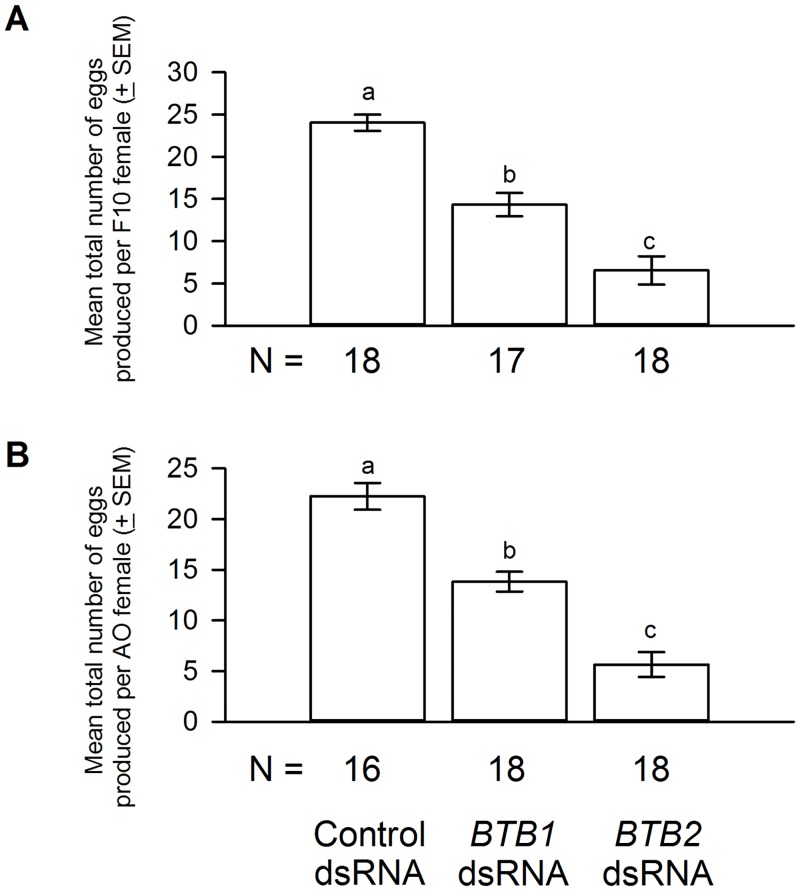
Functional effects of BTB1 and BTB2 dsRNA deliveries.
BTB1 and BTB2 dsRNA deliveries significantly reduced egg production of F10A (A) or AO (B) females: One-way ANOVA, F
2,52 = 41.18 and F
2,51 = 48.17 for F10A and AO females, respectively; P < 0.0001 for both F10A and AO females, Tukey-Kramer HSD lettering for all comparisons. N represents the number of biological replicates.